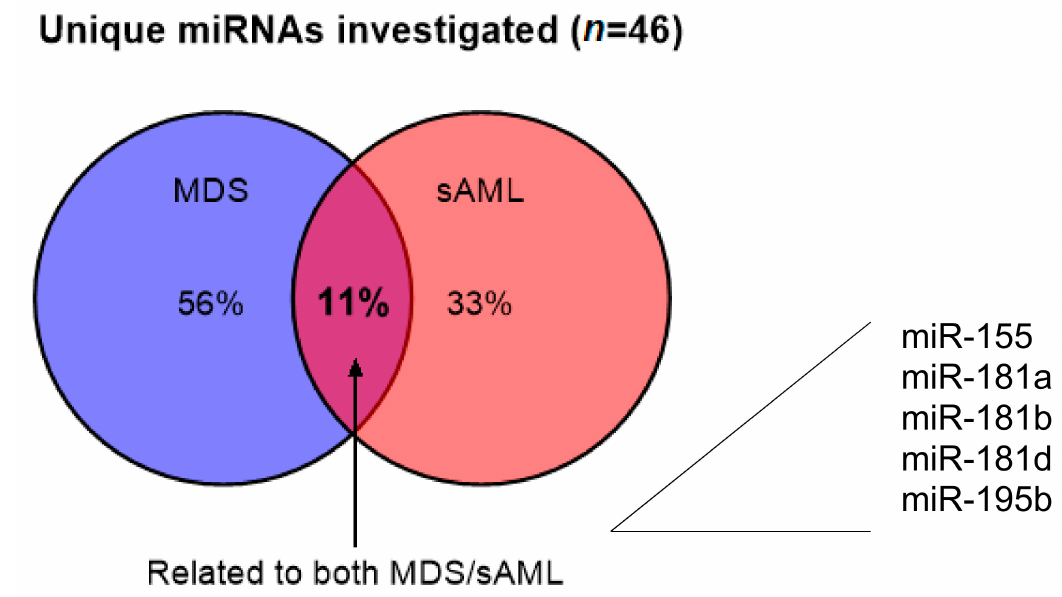
Figure 2. Frequency of dysregulated miRNAs in MDS and sAML. Close to 89% of the investigated miRNAs ( n = 46) showed a deregulation of miRNA in MDS or sAML when compared to healthy controls, in which 33% are sAML-related and 56% are MDS-related. Approximately 11% of deregulated miRNAs overlapped in both diseases